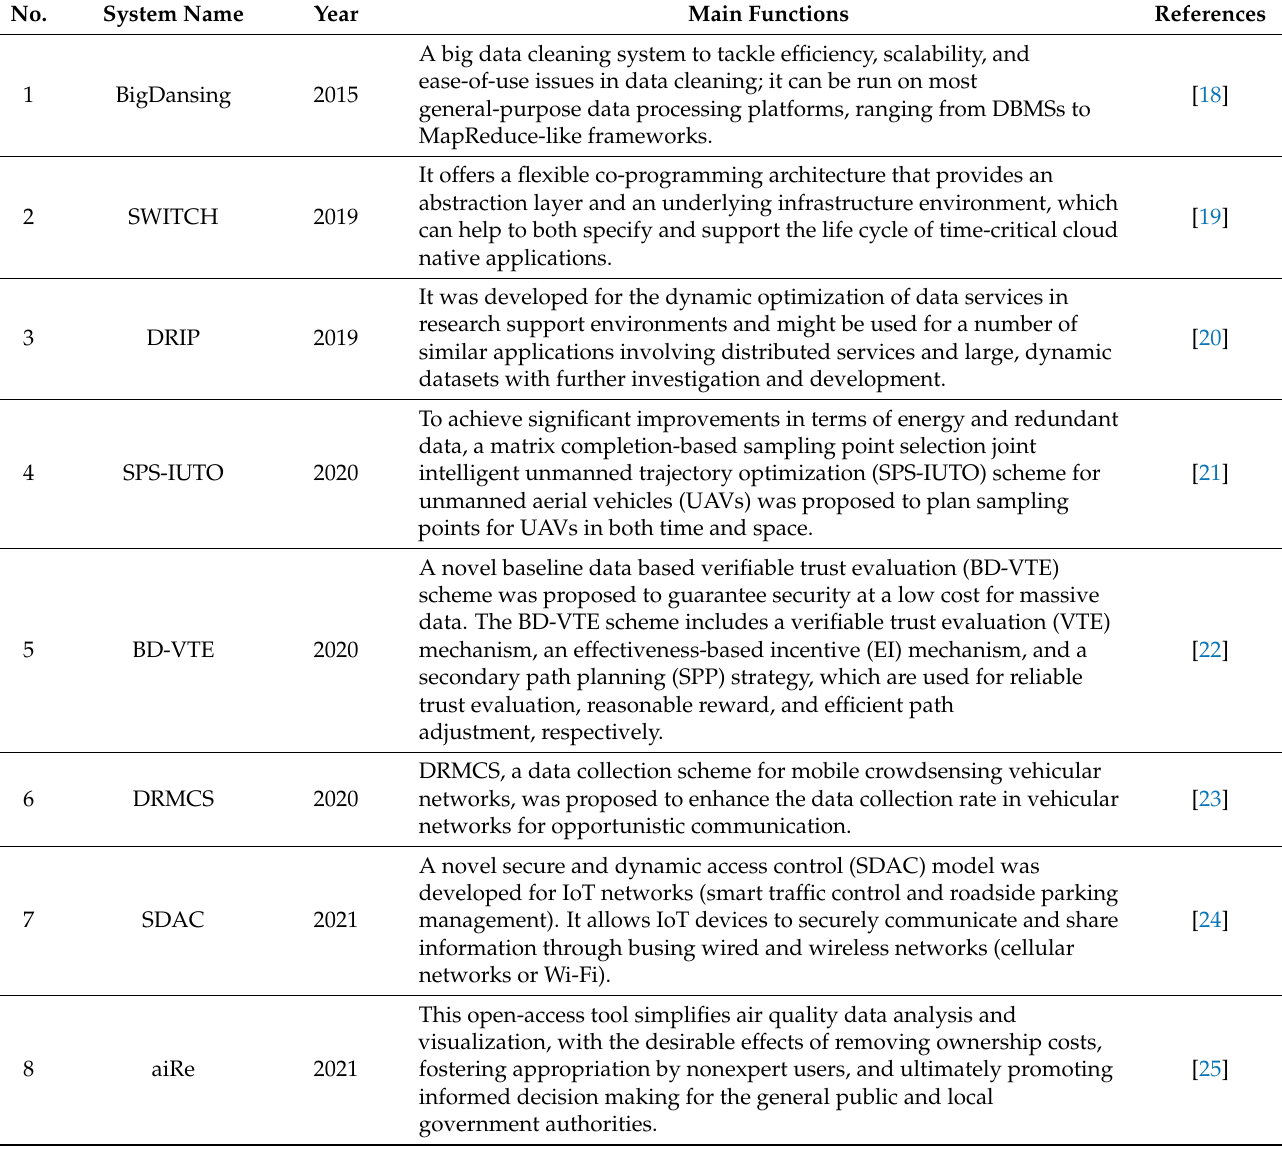
Table 1. Typical instances of big data processing systems. Main